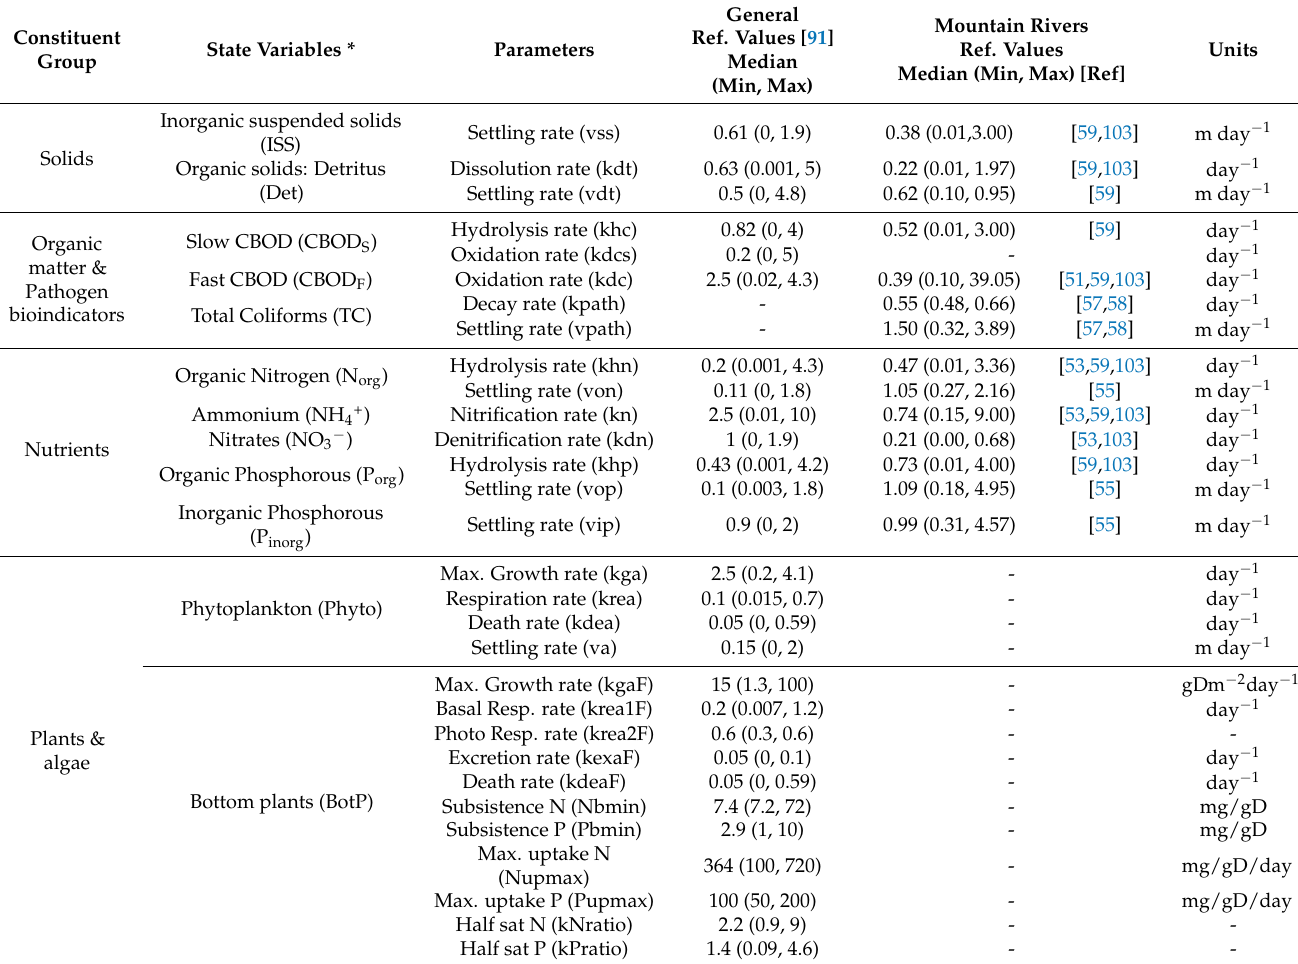
Table 3. State variables and parameters for